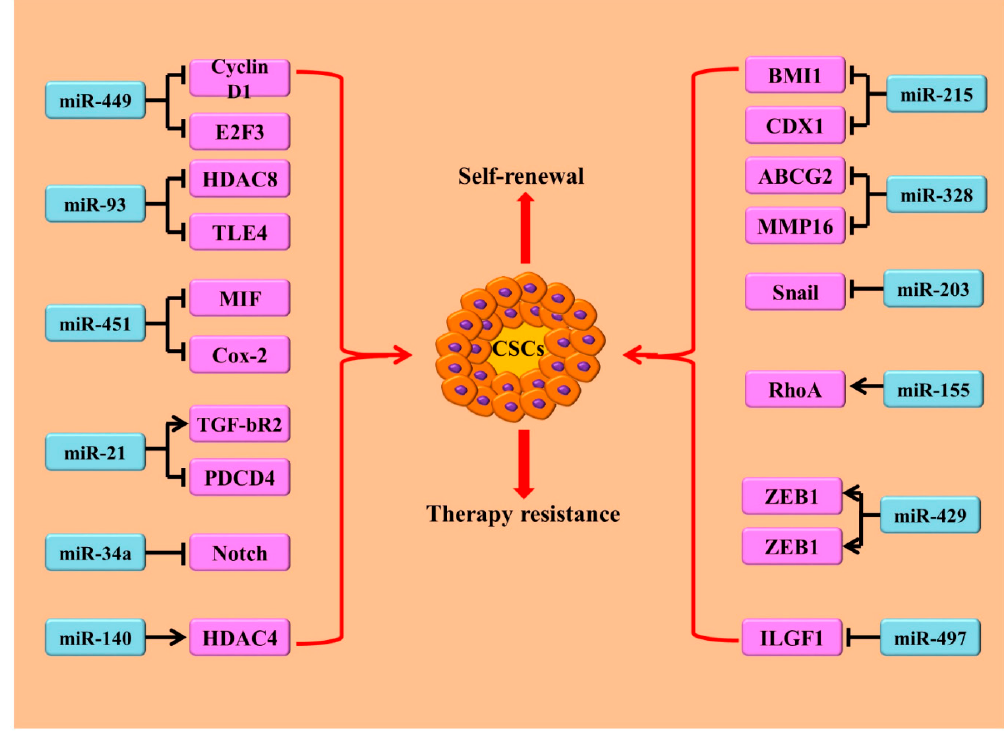
Figure 3. miRNAs in regulating characteristics of CSCs in colorectal carcinoma (CRC): miRNAs can both inhibit or stimulate the development and characteristics of CSCs, such as the ability of self-renewal, therapy resistance, etc. These changes are through targeting signalling pathways, transcription